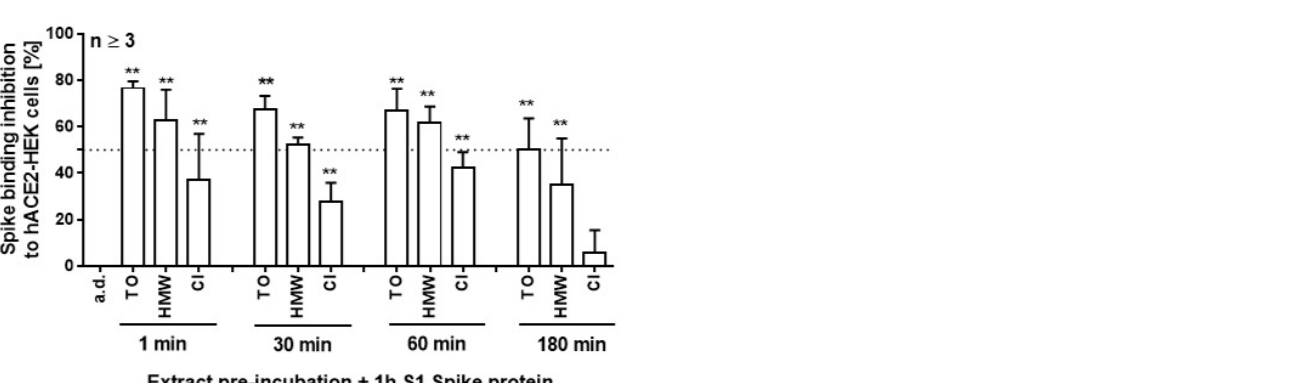
Figure 3. Binding inhibition of S1 spike protein to human HEK293-hACE2 cells by extract pre-incubation. Cells were pre-incubated for the indicated times with 10 mg/mL T. officinale (TO), its HMW fraction, equal to 10 mg/mL extract (HMW), and 10 mg/mL C. intybus (CI) or solvent control (a.d.) and subsequently treated with His-tagged S1 spike protein for 1 h without a washing step in between at 4 ◦ C. Binding inhibition was assessed using flow cytometry. N = 3, bars are means + SD. Upper left: cytogram of gated HEK-hACE2 cells. Middle: overlay of representative fluorescence intensity histograms for ACE2 surface expression. Upper right: overlay of representative fluorescence intensity histograms for spike-binding inhibition by the extracts or a.d.; positive control: 20 µ g/mL soluble hACE2. Cells were stained with anti-His-tag Alexa Fluor 647 conjugated monoclonal antibody; ** p < 0.01. Significance of difference was calculated relative to the solvent control by one-way